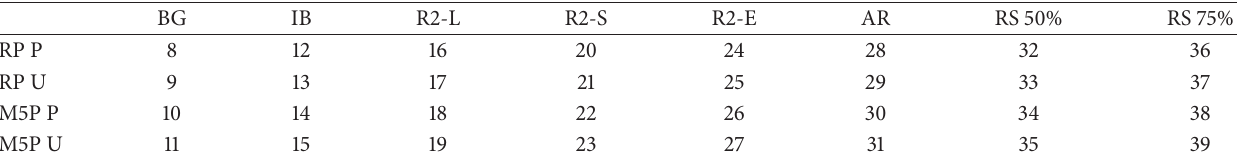
Table 11: Index notation for the ensemble methods.